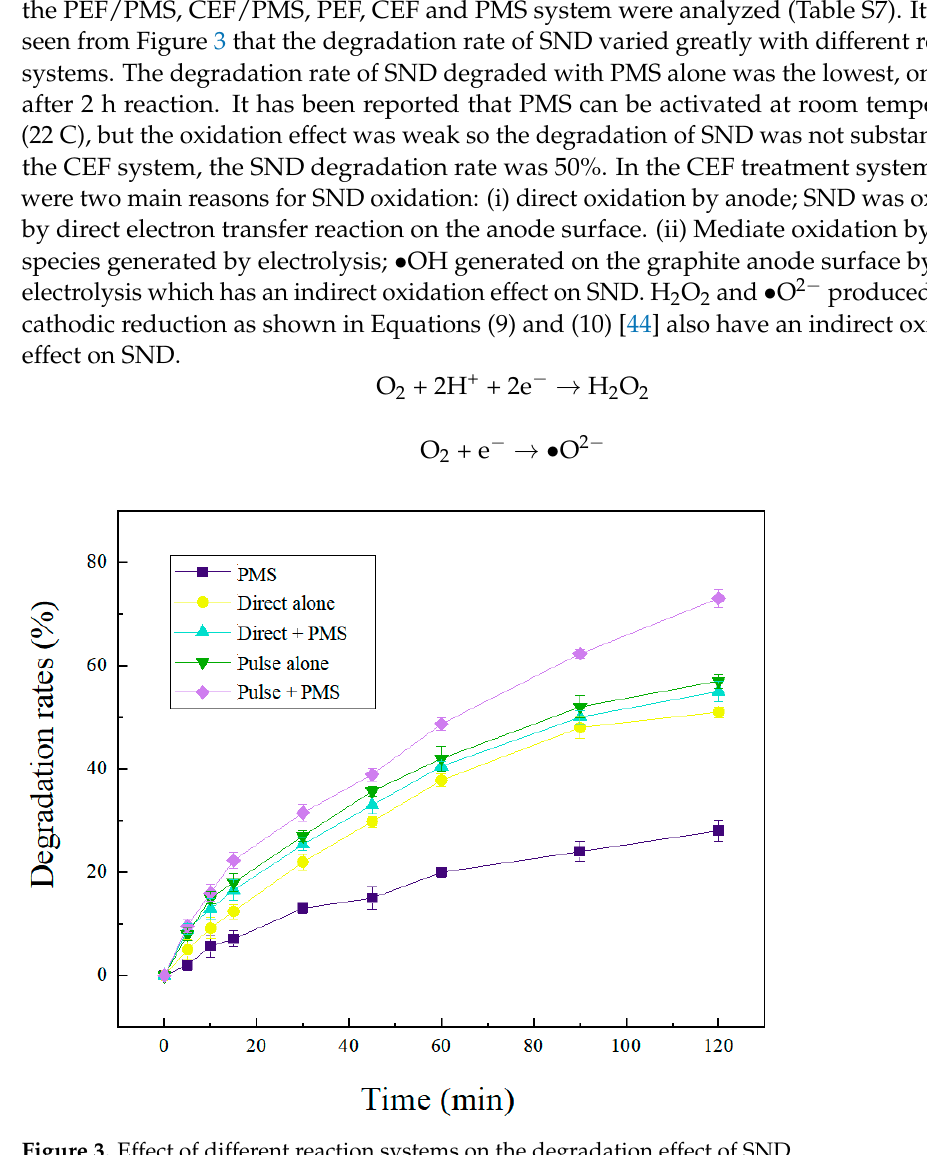
Figure 3. E ff ect of di ff erent reaction systems on the degradation e ff ect of SND. Figure 3. Effect of different reaction systems on the degradation effect of